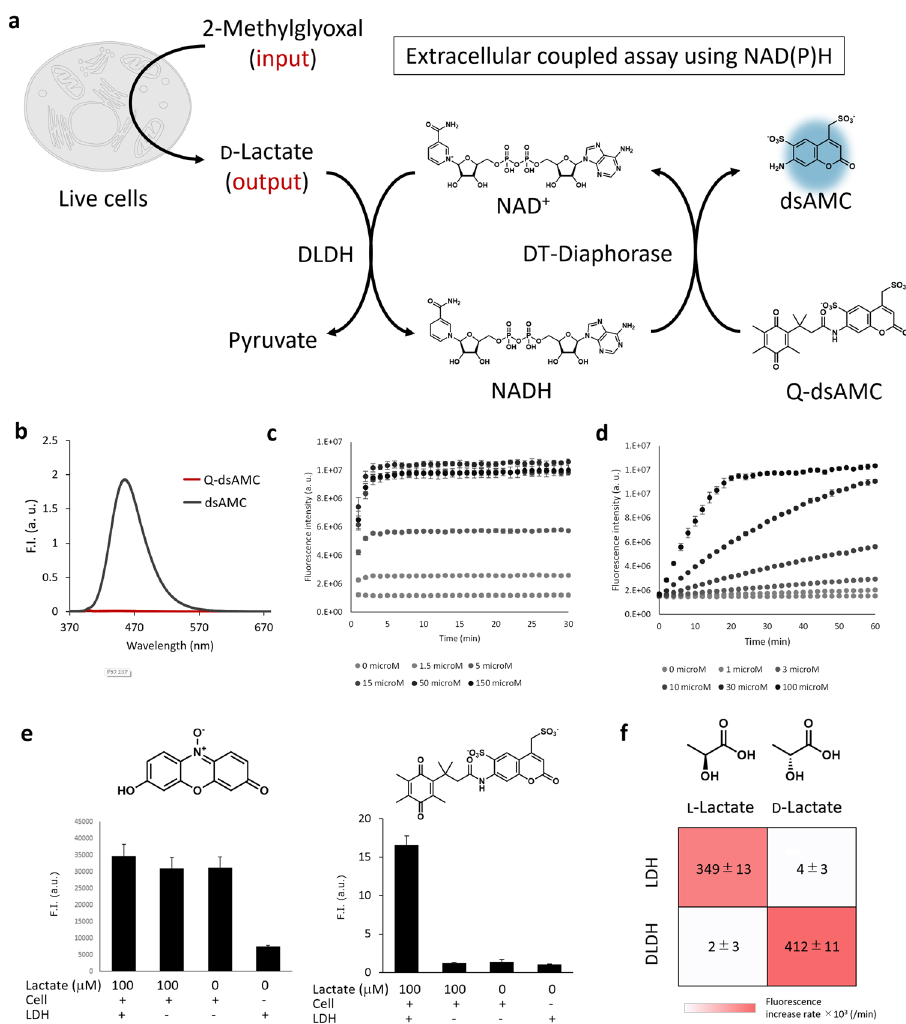
Fig. 2 Design of fl uorogenic probe for extracellular metabolite detection via NAD(P)H-coupled assay. a Structure of Q-dsAMC and the design of live cell-based coupled assay. b Fluorescence spectra ( λ ex. = 360 nm) of 1 μ M probes (Q-dsAMC and dsAMC) in PBS (pH 7.4) containing 0.1% DMSO as a co- solvent. c Fluorescence intensities of Q-dsAMC (10 mM) after mixing with NADH (0 – 150 μ M), DT-diaphorase (5 μ g/mL) in DPBS (pH 7.4) containing 0.1% CHAPS. Error bars represent S.D. ( n = 4). d Fluorescence intensities of Q-dsAMC (10 μ M) after mixing with D -lactate (0 – 100 μ M), NAD + (100 μ M), DT-diaphorase (5 μ g/mL), and D -lactate dehydrogenase (2.5 U/mL) in DPBS (pH 7.4). Error bars represent S.D. ( n = 3). e Fluorescence intensities of (left) resazurin (1 μ M) or Q-dsAMC (1 μ M) after mixing with A549 cells (1 × 10 5 cells/mL), L -lactate (0 or 100 μ M), NAD + (100 μ M), DT-diaphorase (1 U/mL), and lactate dehydrogenase (LDH) (0 or 1 μ g/mL) in DPBS (pH 7.4). f Fluorescence intensities of Q-dsAMC (10 μ M) after mixing with NAD + (100 μ M), L -lactate or D -lactate (100 μ M) with LDH or D -lactate dehydrogenase (DLDH) (5 μ g/mL) in PBS (pH 7.4) containing 0.1% CHAPS and incubated for 10 min. The value is mean ± S. D. ( n =